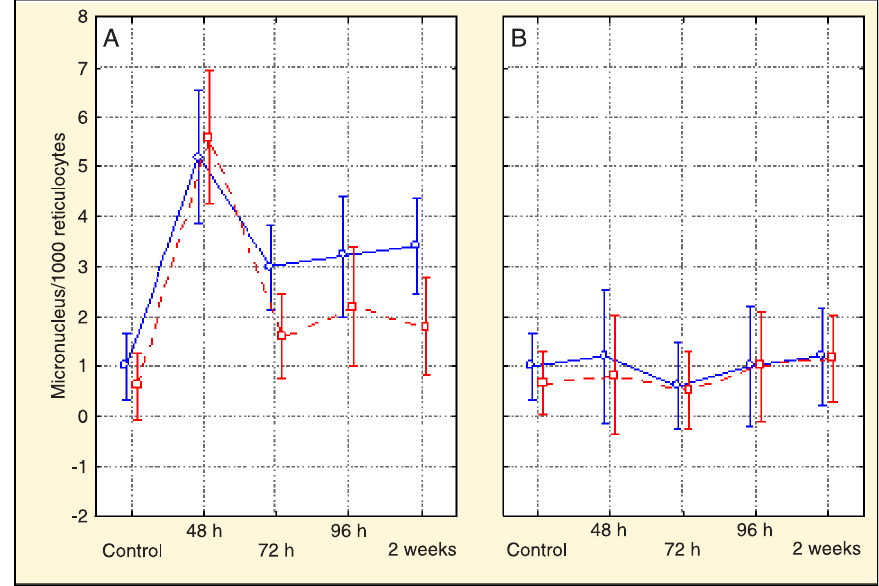
Figure 2. Micronucleus frequency in A , 3- and B , 12-week-old male (blue full line) and female (red dashed line) mice exposed to 0.05 µg/kg diethylstilbestrol. For each dose, age and sex, 5 animals were analyzed. Micronucleus frequency is reported as per 1000 reticulocytes. Vertical bars indicate 95% confidence intervals. ANOVA for repeated measurements was used to compare responses at each sampling